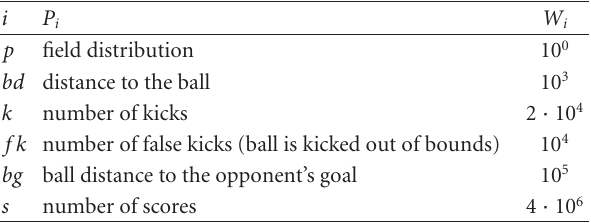
Table 2: Parameters of the fitness function.